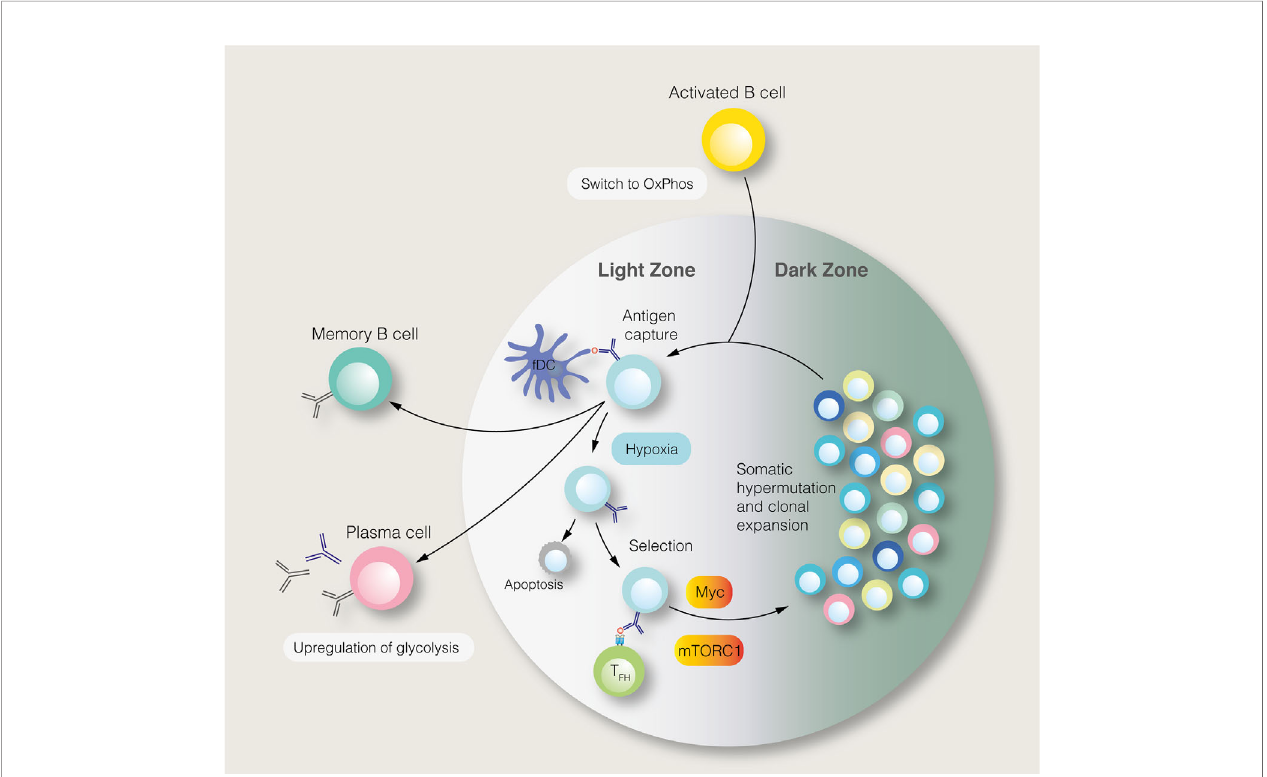
FIGURE 2 | The germinal centre reaction and its regulation by metabolic signals. In the germinal centre light zone, centrocytes capture antigens from follicular dendritic cells (fDC). Centrocytes with the highest antigen af fi nities are most likely to acquire antigens and present antigen – derived peptides to follicular helper T (T FH ) cells. Centrocytes which receive pro – survival signals from T FH cells may migrate to the dark zone, where, as centroblasts (CB), they undergo somatic hypermutation and clonal expansion. This process generates B cells with new antigen speci fi cities. The proliferation of centroblasts is enabled by mTORC1 and c – Myc signalling in the light zone, although this anabolic phenotype is restrained by germinal centre hypoxia. Instead of entering the dark zone, centrocytes, may differentiate into long – lived plasma cells and memory B